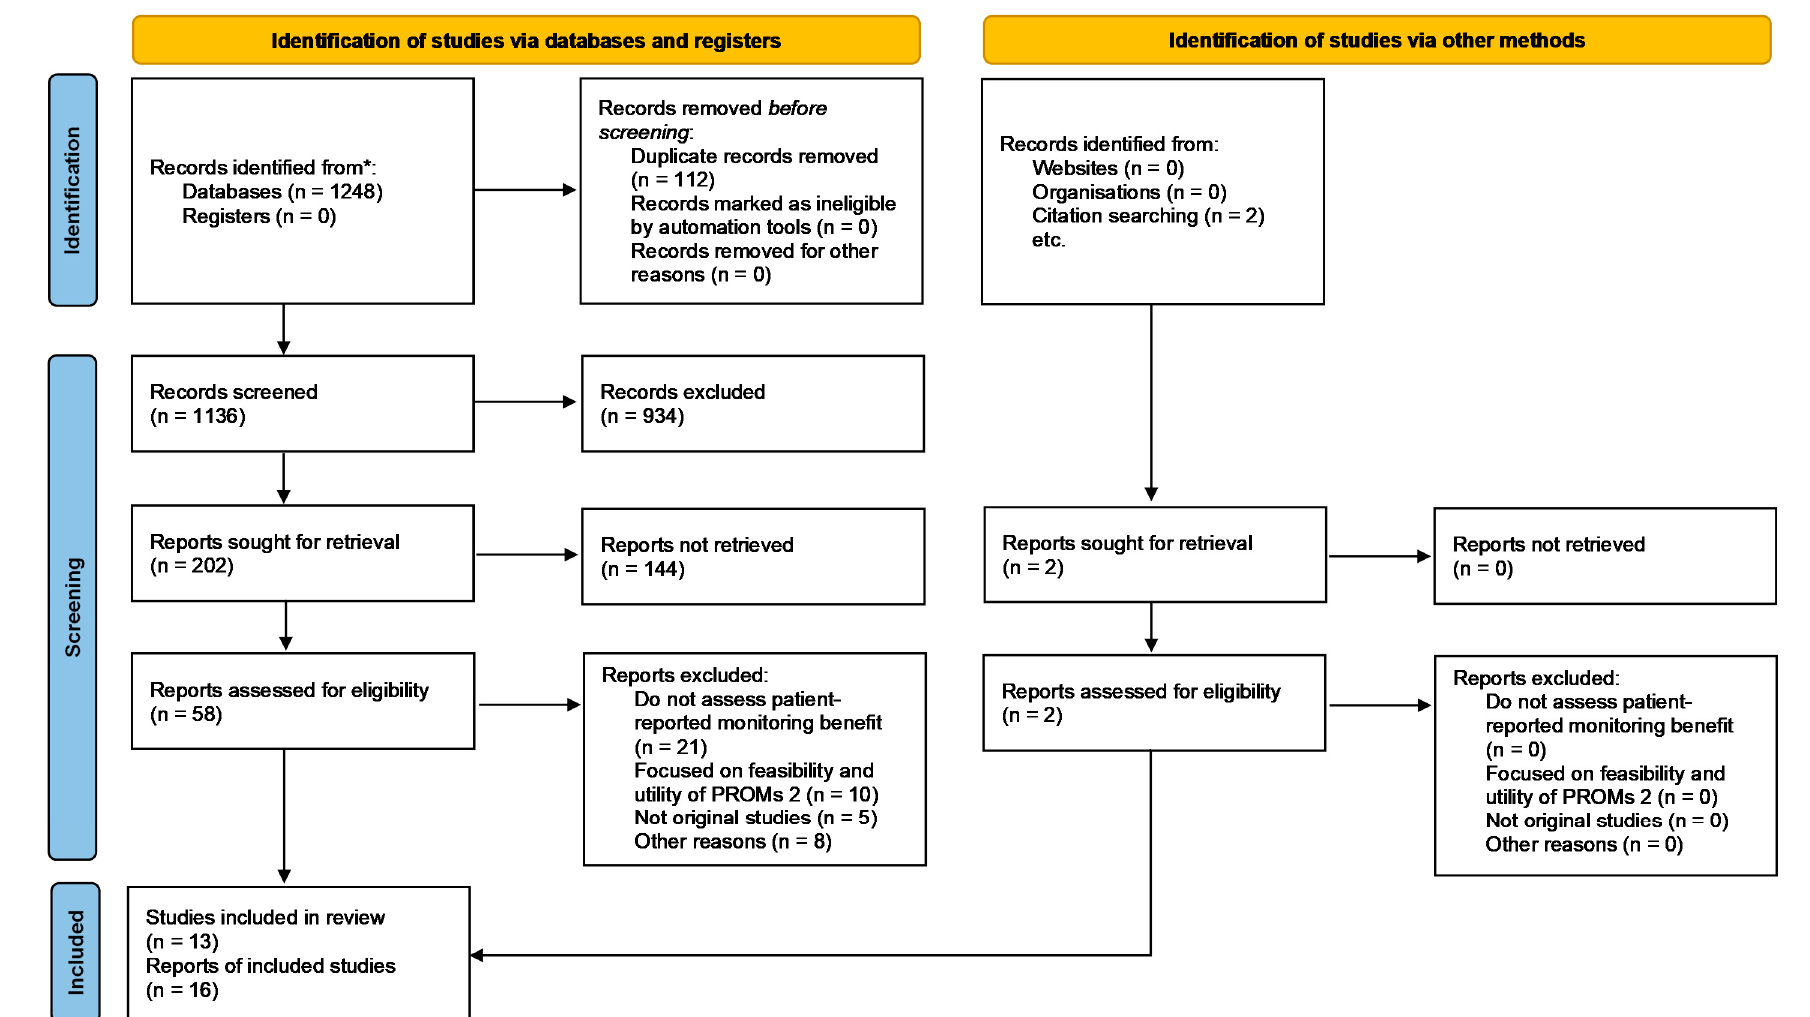
Figure 1. PRISMA flow diagram. * MedLine/PubMed database.